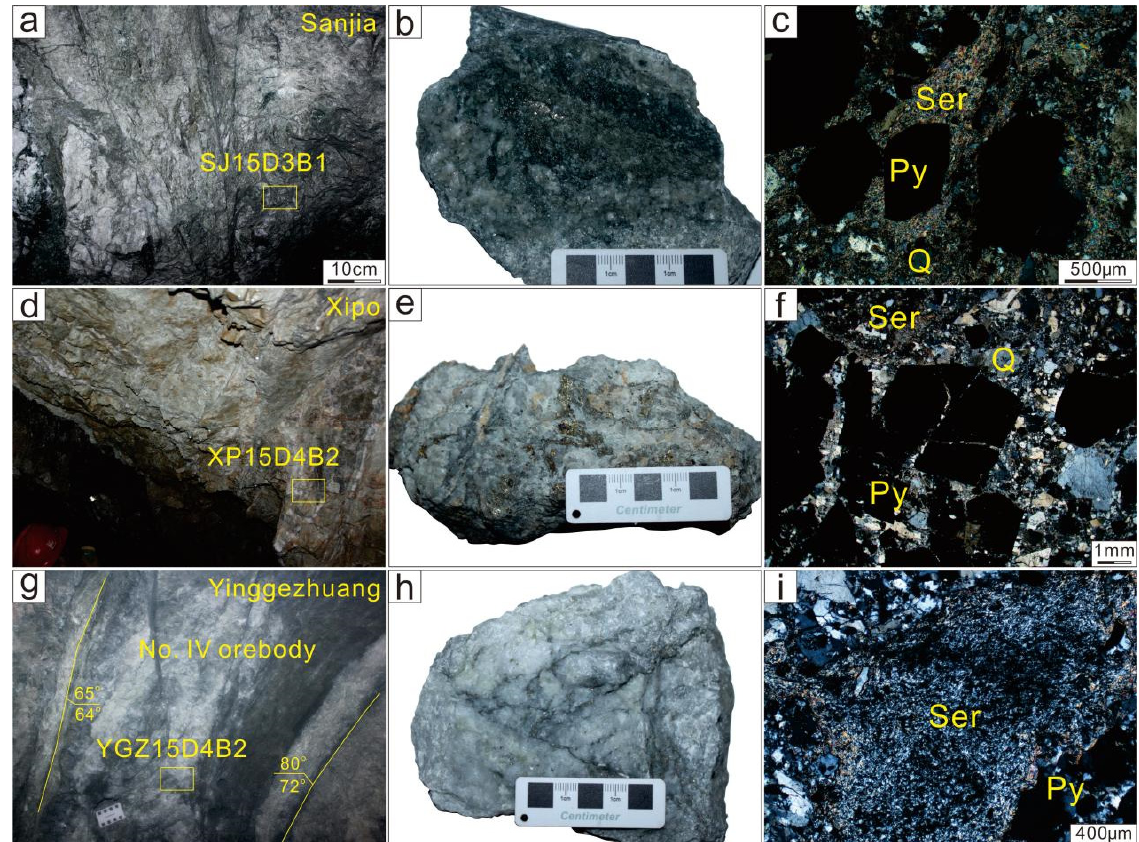
Figure 4. Sampling location and microscopic image showing the relationship between muscovite and mineralization in the Sanjia, Xipo, and Yinggezhuang gold deposits: ( a ) sampling location of the beresite in the Sanjia gold deposit, ( b ) hand sample of beresite, ( c ) muscovite coexists with pyrite, ( d ) sampling location of the quartz–sulfide vein in the Xipo gold deposit, ( e ) hand sample of quartz–sulfide vein, ( f ) muscovite coexists with pyrite, ( g ) sampling location of the quartz–sulfide vein in the Yinggezhuang gold deposit, ( h ) hand sample of quartz–sulfide vein, ( i ) muscovite coexists with pyrite. Py—pyrite; Ser—muscovite; Q—quartz. The yellow square shows the sampling location. The pyrite, quartz, and muscovite coexist, and muscovite had a fine-grained structure, as shown in Figure 4c,f,i when viewed under a microscope. The selected muscovite